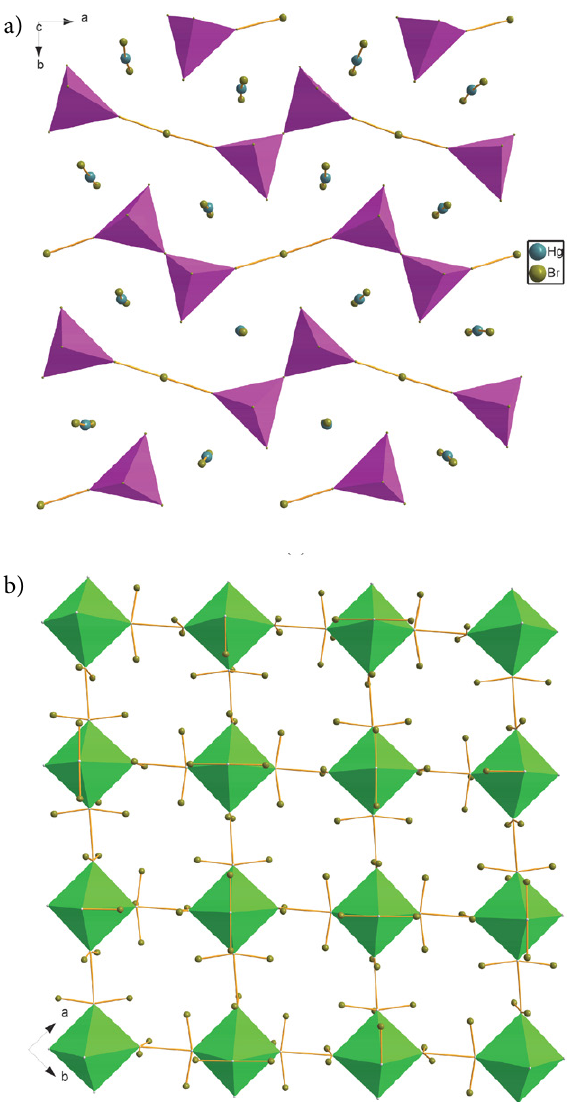
Figure 2. (a) The Hg-Br layer with the purple polyhedra represent- ing the HgBr 4 tetrahedra and (b) the Hg-Dy-Br layer with the green polyhedra representing the HgDy 6